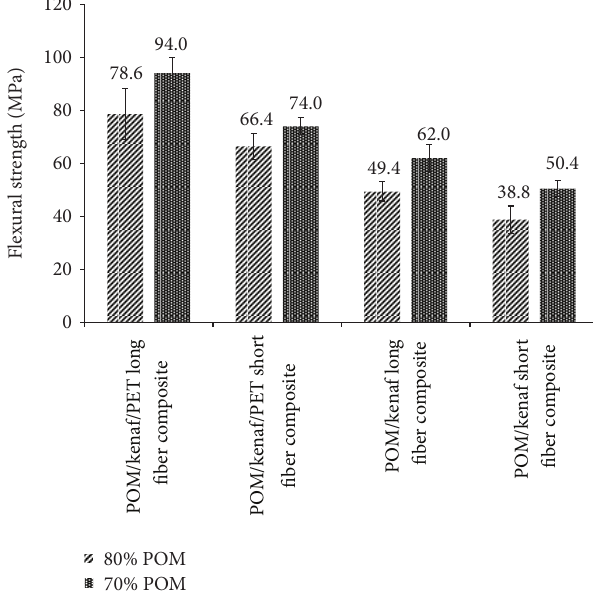
Figure 8: Flexural strength of weathered